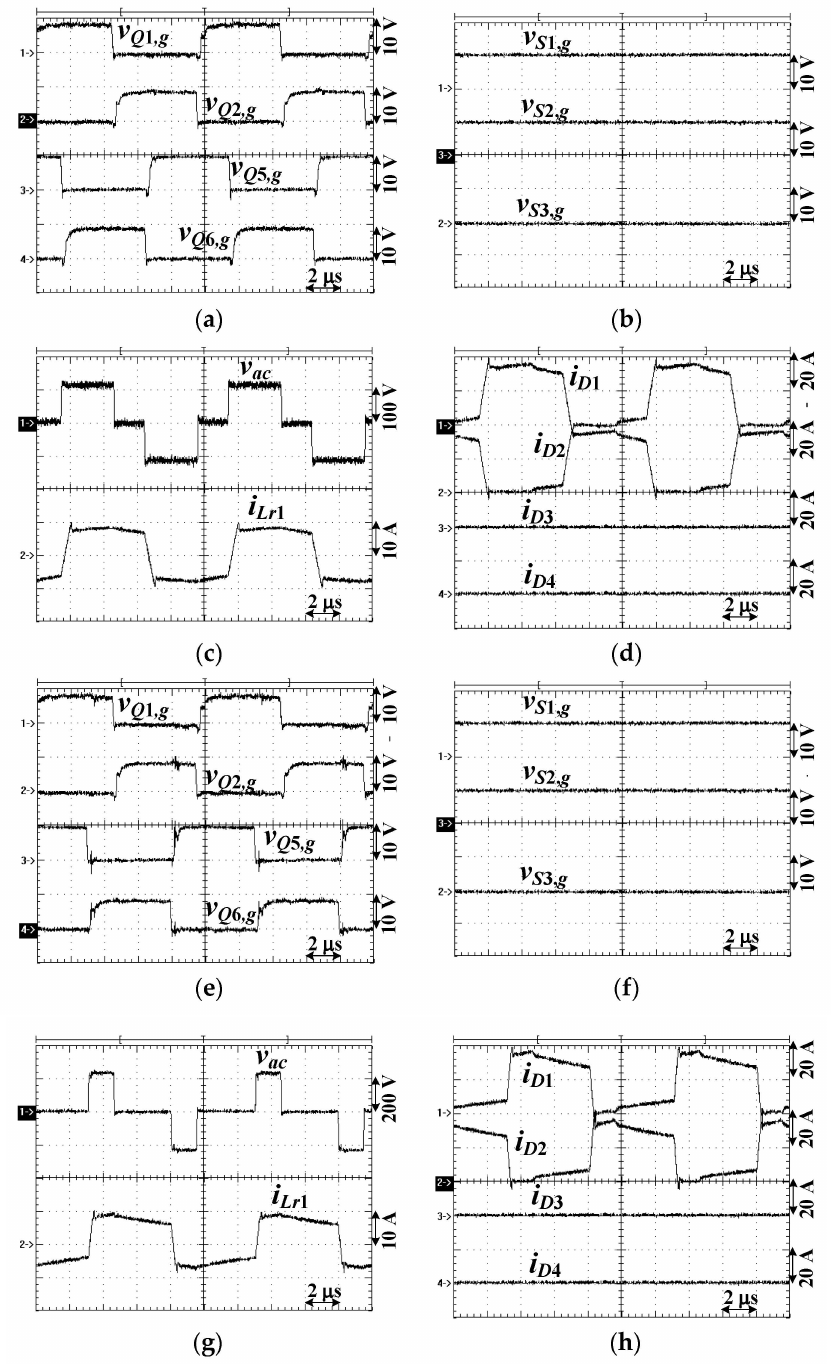
Figure 9. Experimental waveforms under high input voltage range and full load: ( a ) switch waveforms v Q 1 ,g , v Q 2 ,g , v Q 5 ,g , and v Q 6 ,g at V in = 117 V, ( b ) AC switch waveforms v S 1 ,g ~ v S 3 ,g at V in = 117 V, ( c ) v ab and i Lr 1 at V in = 117 V, ( d ) i D 1 ~ i D 4 at V in = 117 V, ( e ) switch waveforms v Q 1 ,g , v Q 2 ,g , v Q 5 ,g , and v Q 6 ,g at V in = 240 V, ( f ) AC switch waveforms v S 1 ,g ~ v S 3 ,g at V in = 240 V, ( g ) v ab and i Lr 1 at V in = 240 V, and ( h ) i D 1 ~ i D 4 at V in = 240